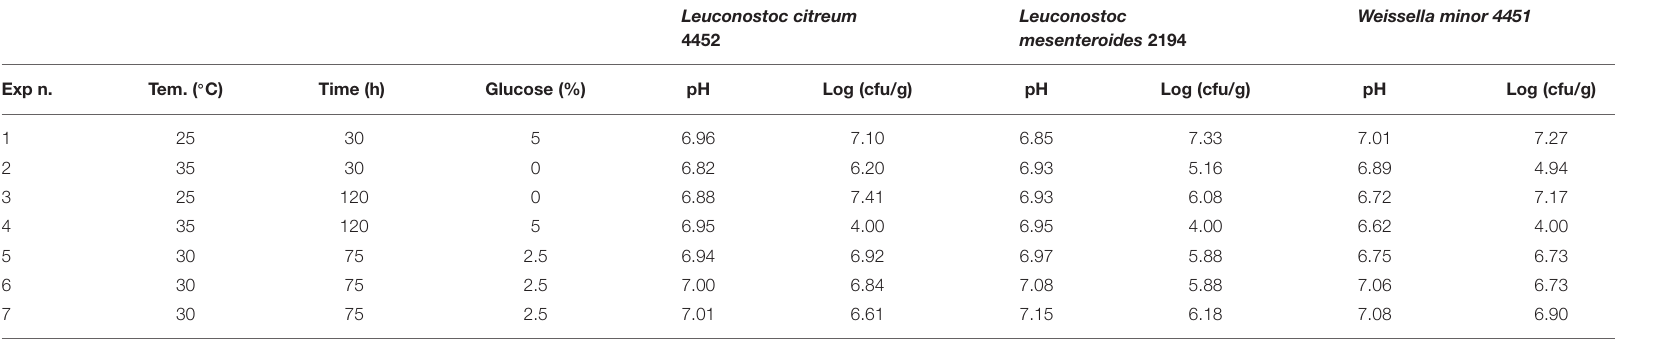
Weissella minor 4451